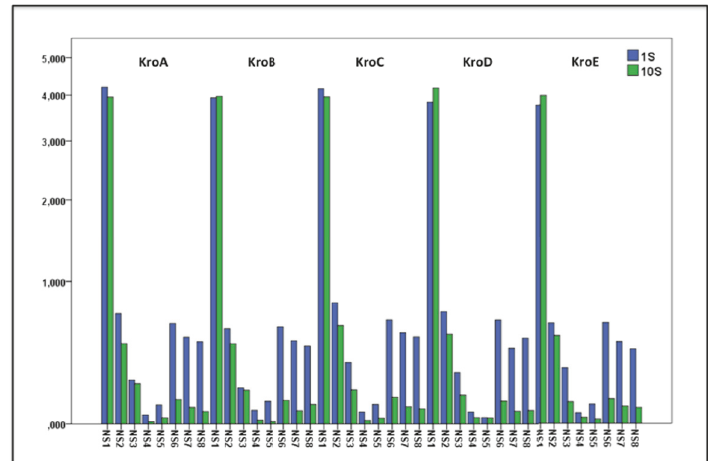
Figure 6: Comparison of the 1 and 10 results for